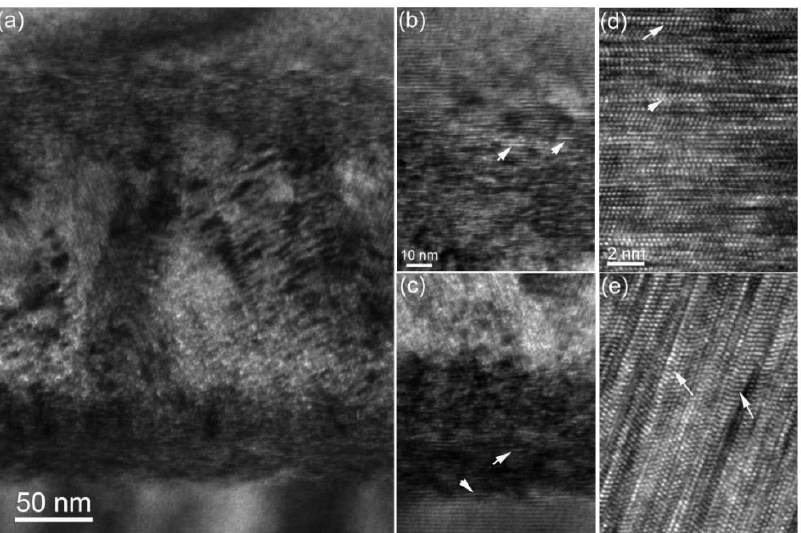
- Figure 4. ( a ) Bright-field XTEM images under two-beam (g = 1100) showing the damaged band in the 6H-SiC after the low fluence implantation. High-resolution images of ( b , d ) in front of the damaged band showing stacking faults indicated by white arrows, ( c ) below the damaged band and ( e ) in the middle of the damaged band, showing columnar grains with many stacking faults.